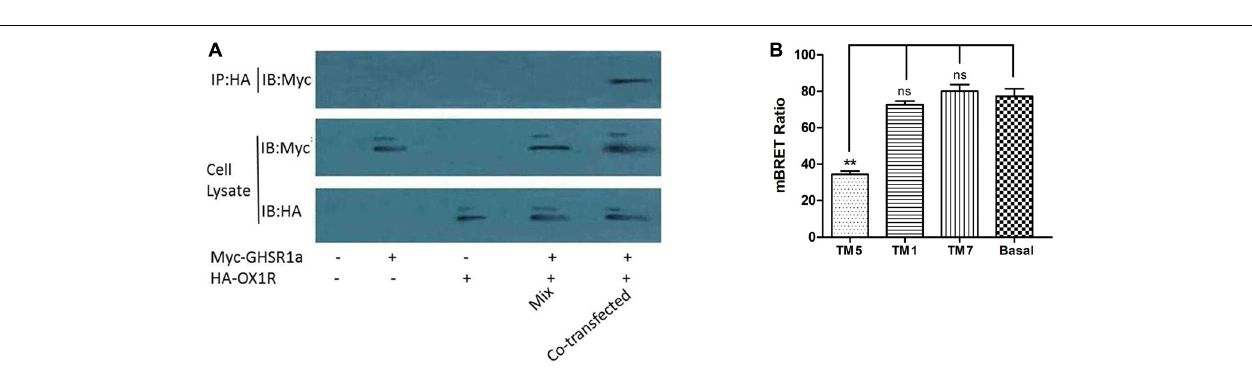
FIGURE 4 | The dimerization of GHSR1a/OX1R and effects of interfering peptides on GHSR1a/OX1R heterodimers. (A) HEK293 cells were either not transfected (mock) or transfected with HA–OX1R, Myc–GHSR1a or both (co-transfection). As negative control, samples containing either HEK293 HA–OX1R cells or HEK293 Myc–GHSR1a cells were mixed (Mix). Cell lysates were immunoprecipitated with anti-HA agarose beads and immunoblotted with anti-Myc antibody (upper panel). Cell lysates were examined by immunoblotting with either an anti-Myc or anti-HA antibody (lower panels). The data represent means ± SEM ( N = 3) of four independent experiments. (B) HEK293 cells were co-transfected with OX1R-Rluc and GHSR1a-EYFP (1:3) and incubated at 37 ◦ C for 2 h with HIV TAT–fused TM peptides (10 µ M) corresponding to TM1, TM5, or TM7 of OX1R. BRET ratios were analyzed and are expressed as the means ± SEM ( N = 3) of four experiments (one-way analysis of variance; ns, not significant, p > 0.05; ∗∗ p < 0.01 vs. control